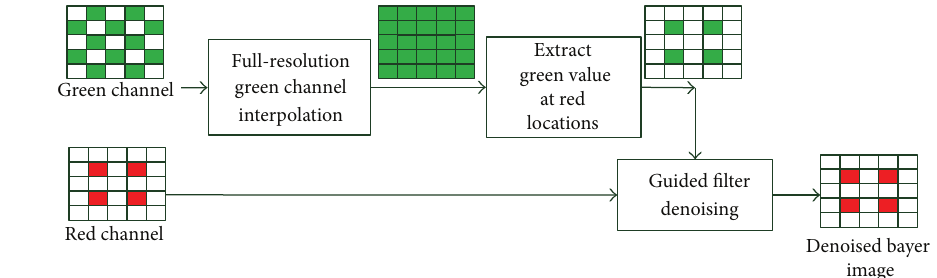
Figure 5: Flow chart of red channel denoising with green channel’s guidance.